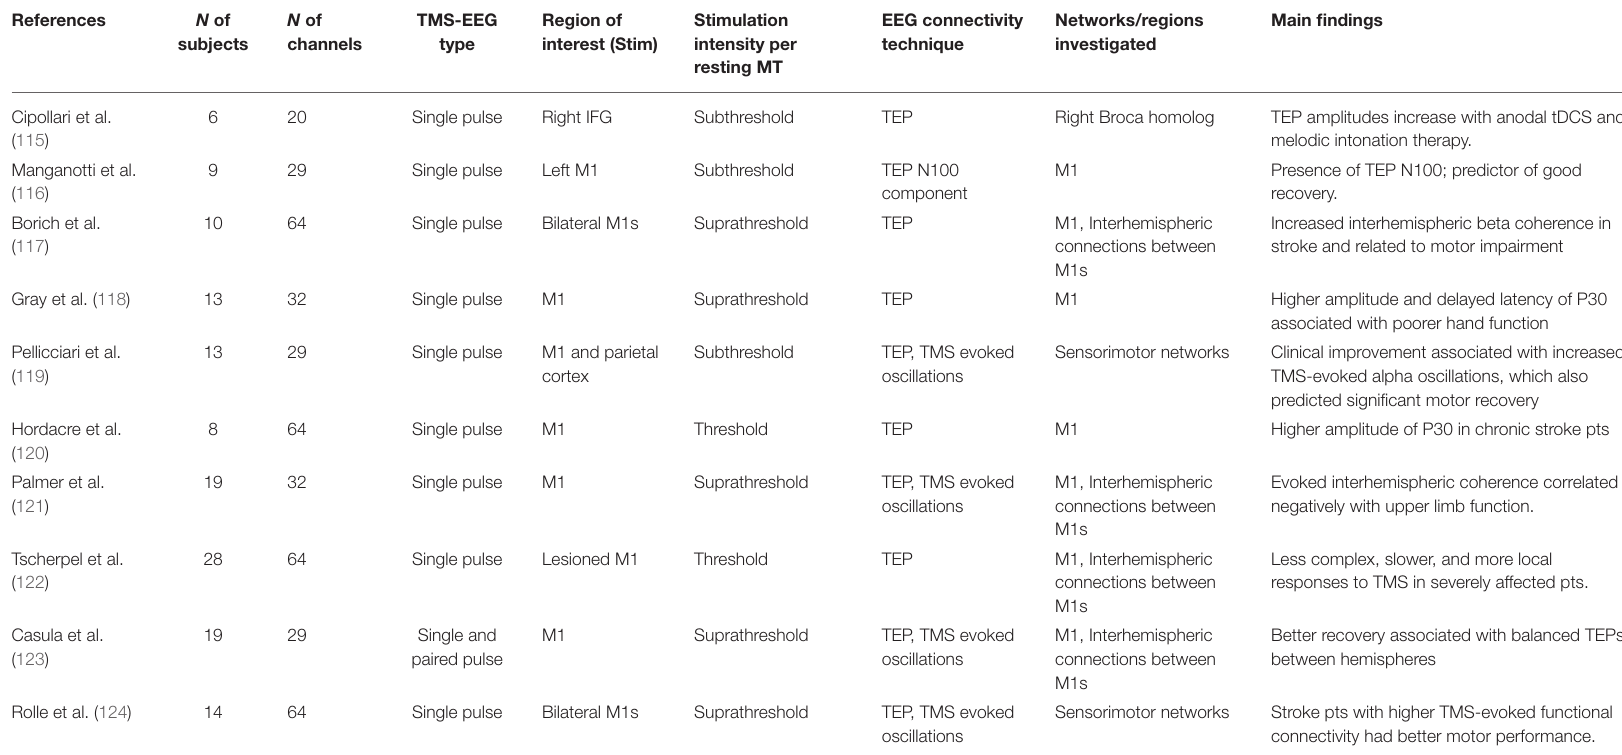
TABLE 5 | TMS-EEG studies in